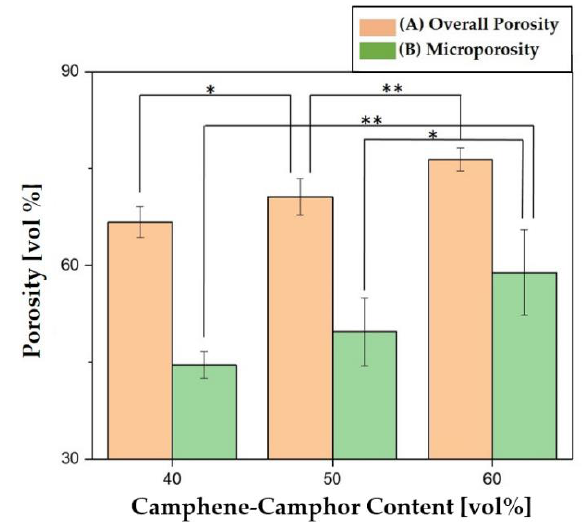
Figure 7. ( A ) Overall porosity and ( B ) microporosity of the hierarchically porous CaP scaffolds manufactured using a range of camphene-camphor amounts (40 vol %, 50 vol %, and 60 vol %). Five samples were tested for each condition (* p < 0.05 and ** p < 0.01).